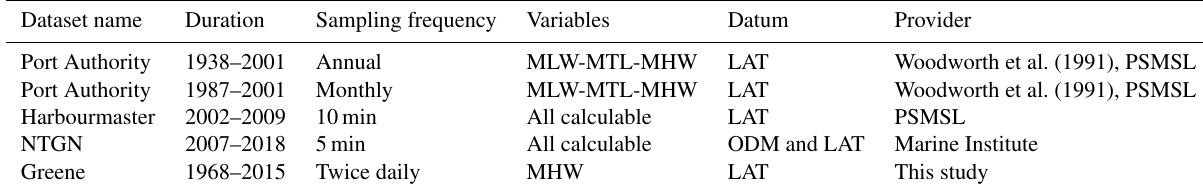
Table 1. Details of the datasets collated to form a complete sea level record for Dublin